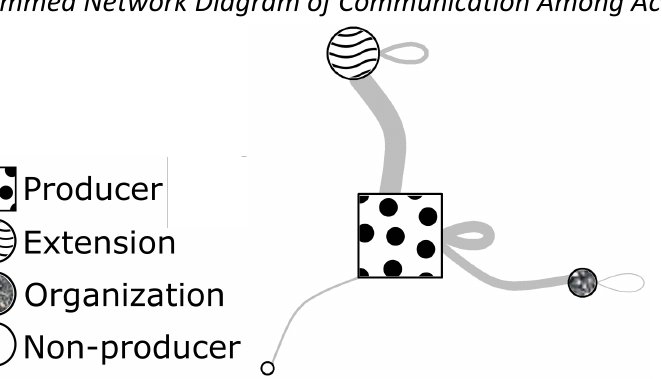
Note . Shape size depicts number of actors per group. Line width indicates number of